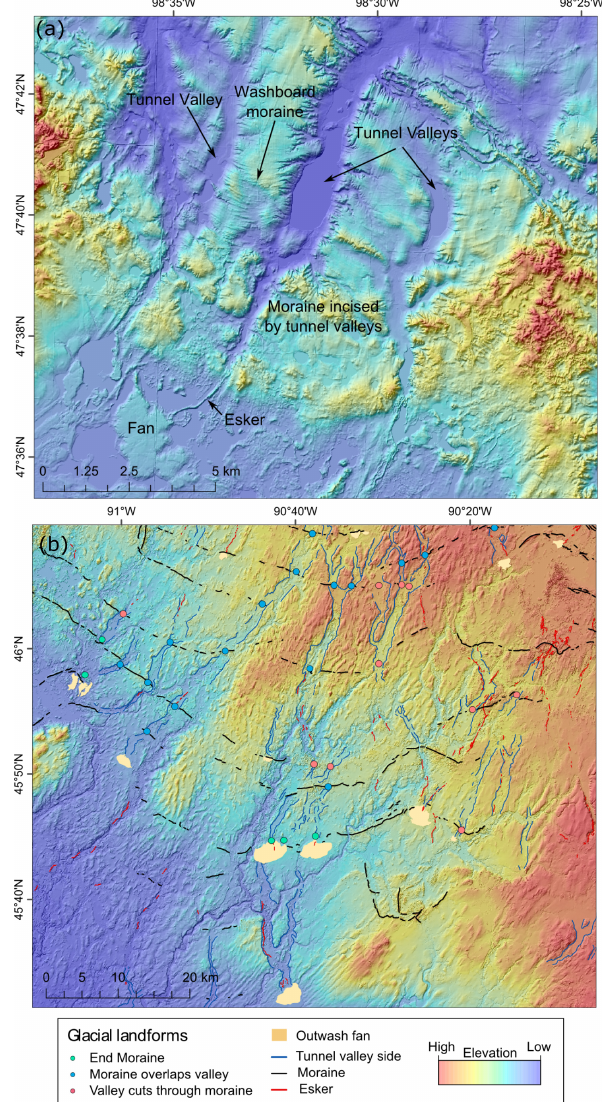
Figure 11. The varied cross-cutting associations between moraines, outwash fans and tunnel valleys in: (a) North Dakota – note how the washboard moraines curve up-glacier towards the tunnel valleys; and (b) Wisconsin (Chippewa